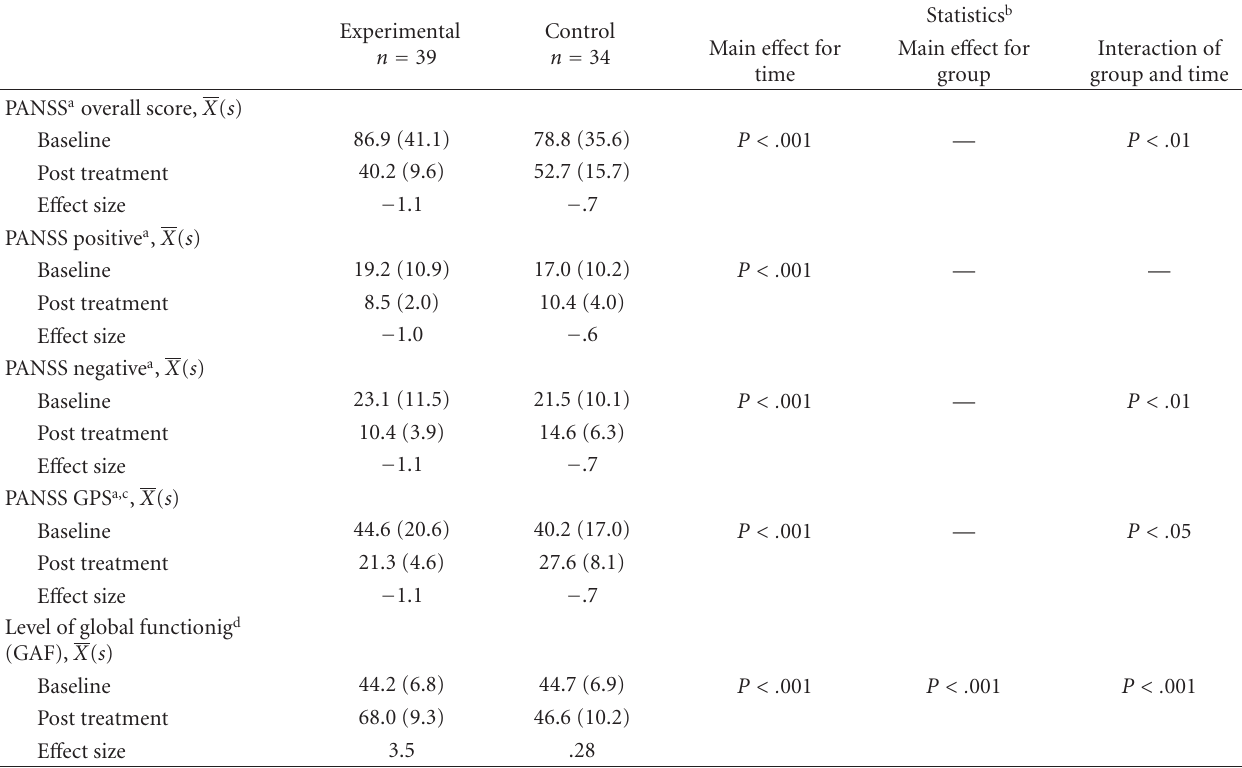
Table 2: Symptomatology (PANSS) and global functioning (GAF) of the study groups at baseline and at the end of treatment. Experimental n = 39